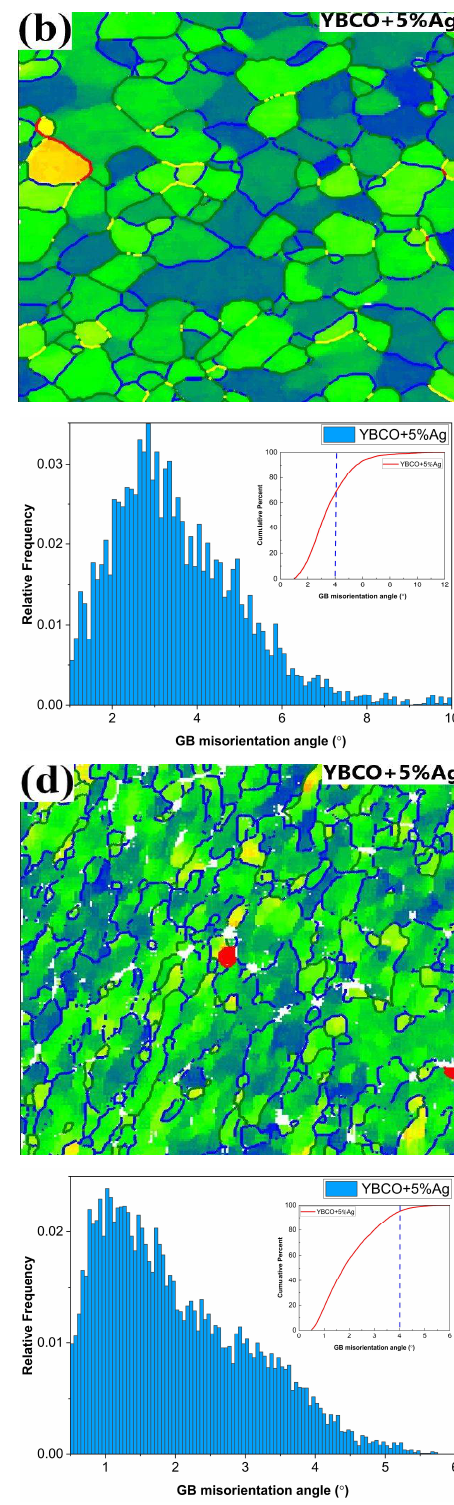
Figure 2. EBSD maps of the absolute misorientation from the ideal cube texture without noise re- duction for undoped and Ag-doped YBCO films on ( a , b ) RABiTS (step size 1.0 µm) and ( c , d ) IBAD−MgO (step size 0.02 µm). White dots are non-indexed areas .